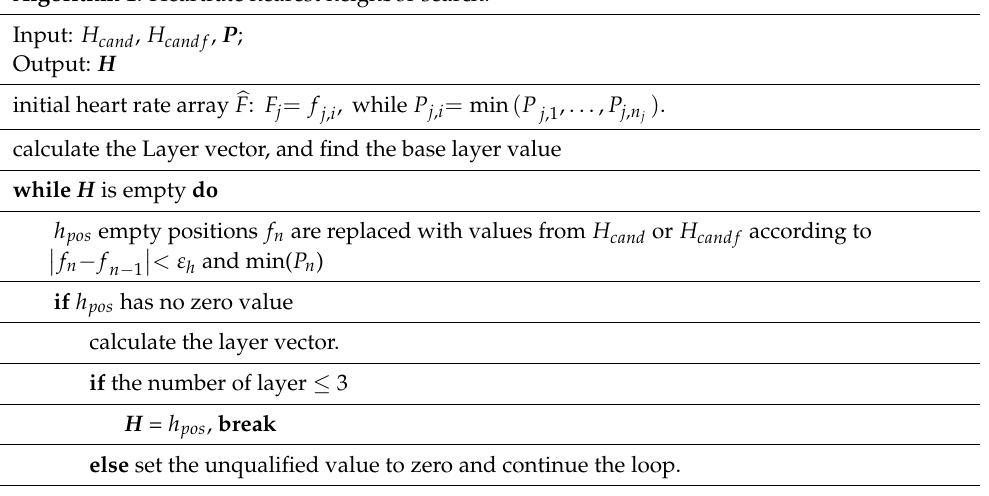
Algorithm 1 . Heartrate nearest neighbor